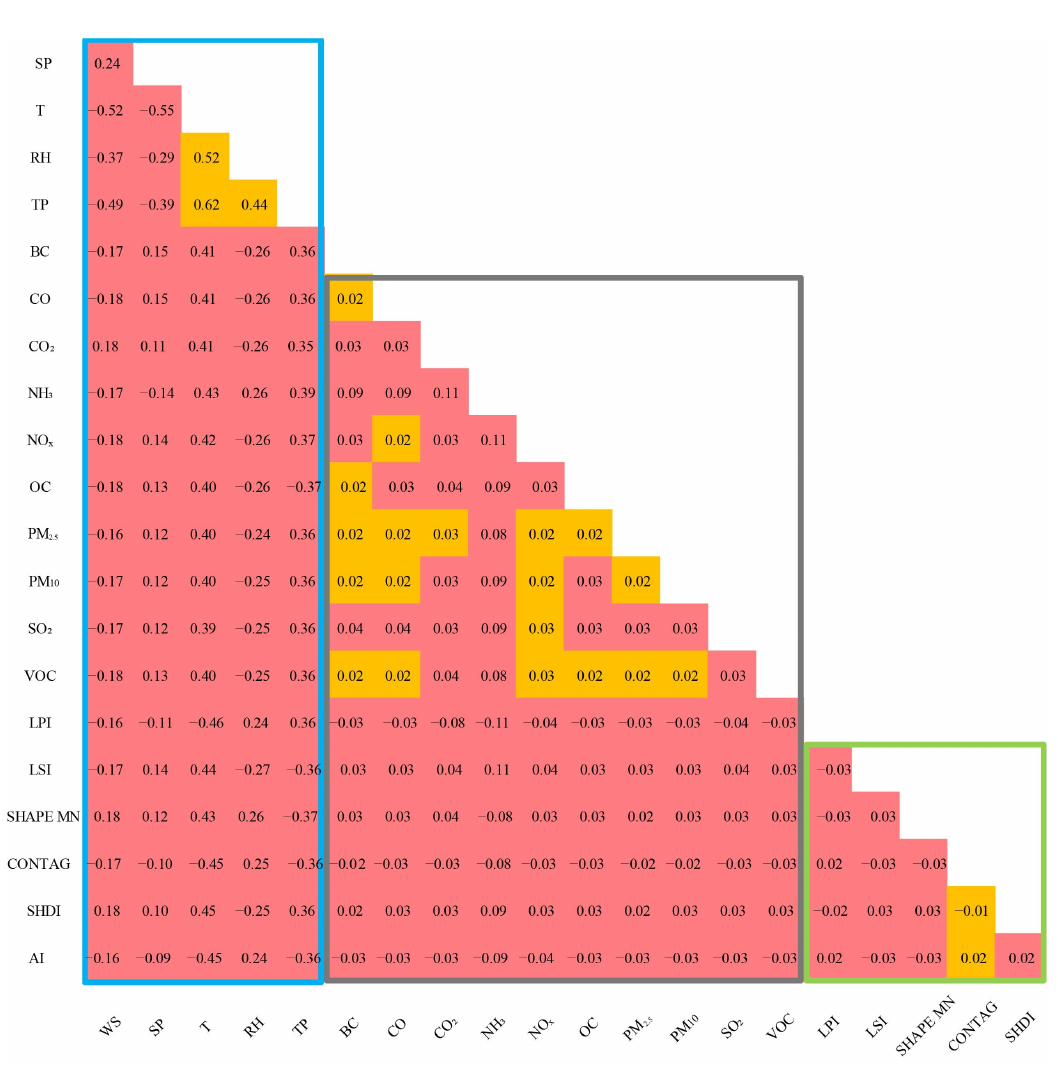
Figure 8. Strength of the interaction between meteorology, anthropogenic emission, and landscape patterns on O 3 concentrations. (Red represents non-linear enhancement, and orange represents double enhancement. The negative sign represents the opposite relationship between the two factors. Blue, grey, and green represent the interaction between each factor and meteorological, emission, and landscape pattern factors, respectively).